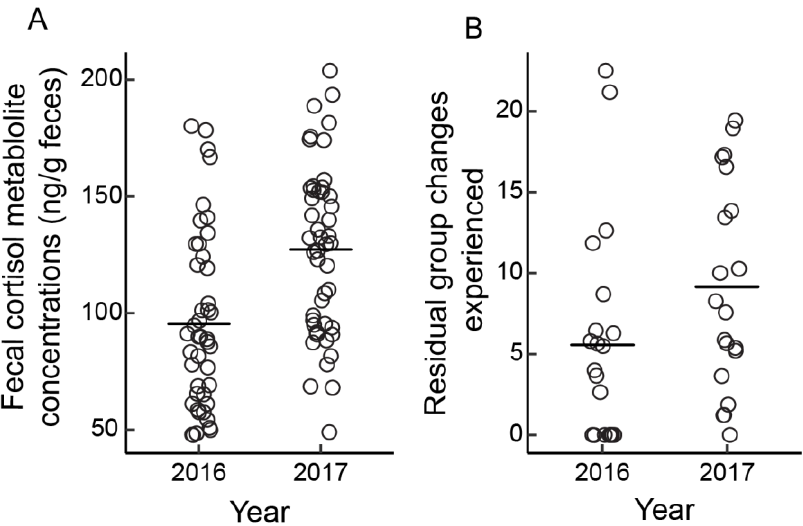
Figure 2. Differences in ( A ) FCM concentrations and ( B ) the number of group changes stallions experienced in the two years of the study. FCM concentrations and the number of group changes were both higher in 2017 than in 2016. Points are jittered to allow clear visualization of all ( A ) fecal samples and ( B ) individual stallions.